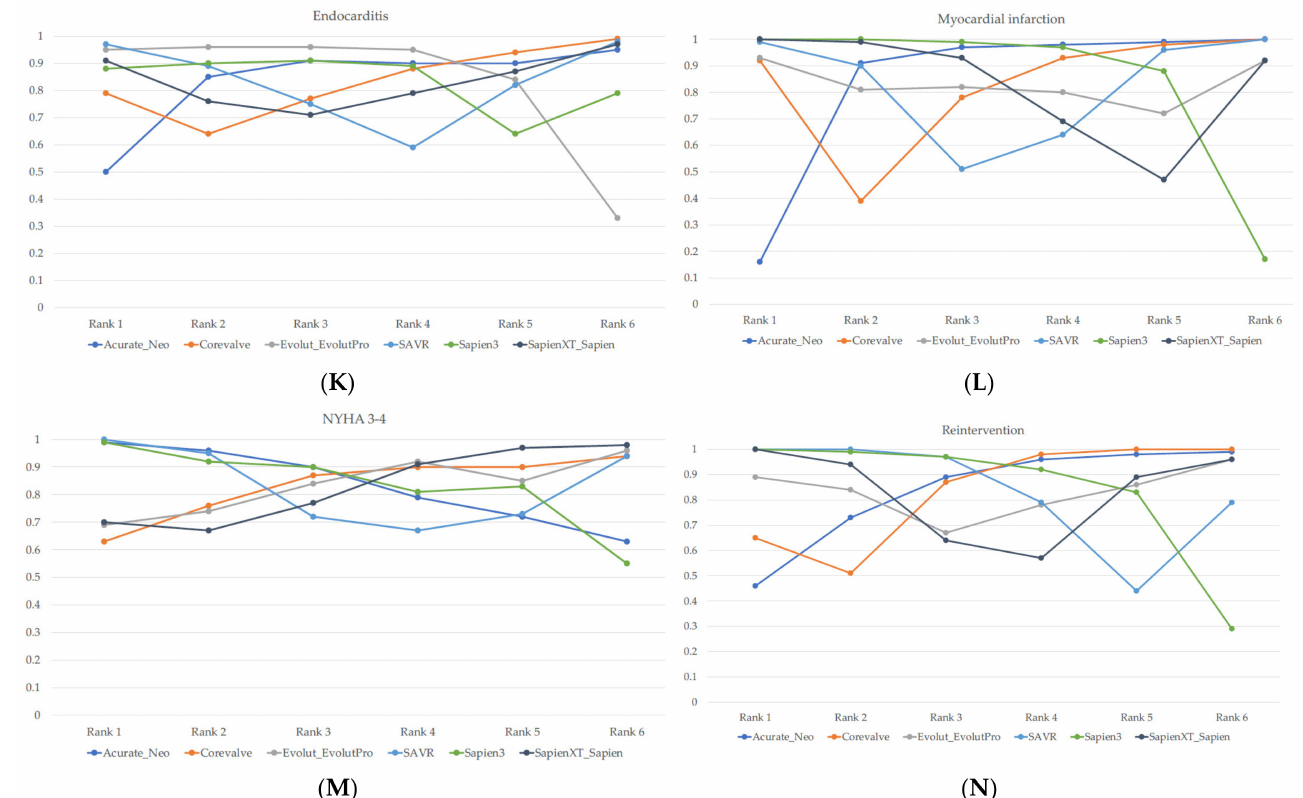
Figure 5. Ranking chart of various TAVI valves and TAVI in ( A ) all-cause mortality, ( B ) cardiovascular mortality, ( C ) stroke, ( D ) bleeding, ( E ) vascular complications, ( F ) acute kidney injury, ( G ) pace-maker implantation, ( H ) rehospitalization, ( I ) atrial fibrillation, ( J ) aortic regurgitation, ( K ) endocarditis,